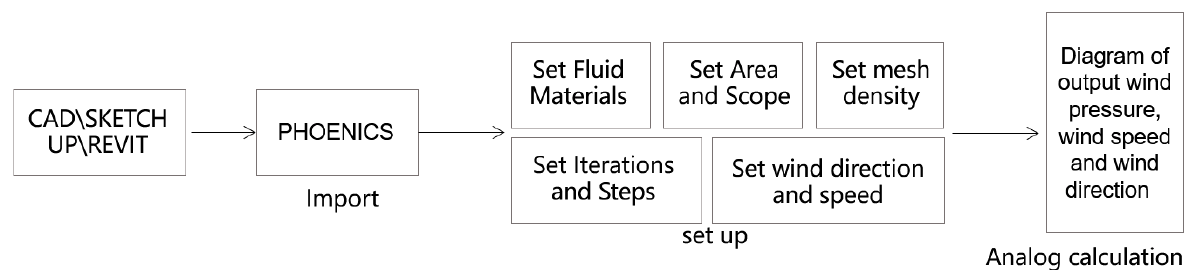
Figure 2. Simulation analysis process.